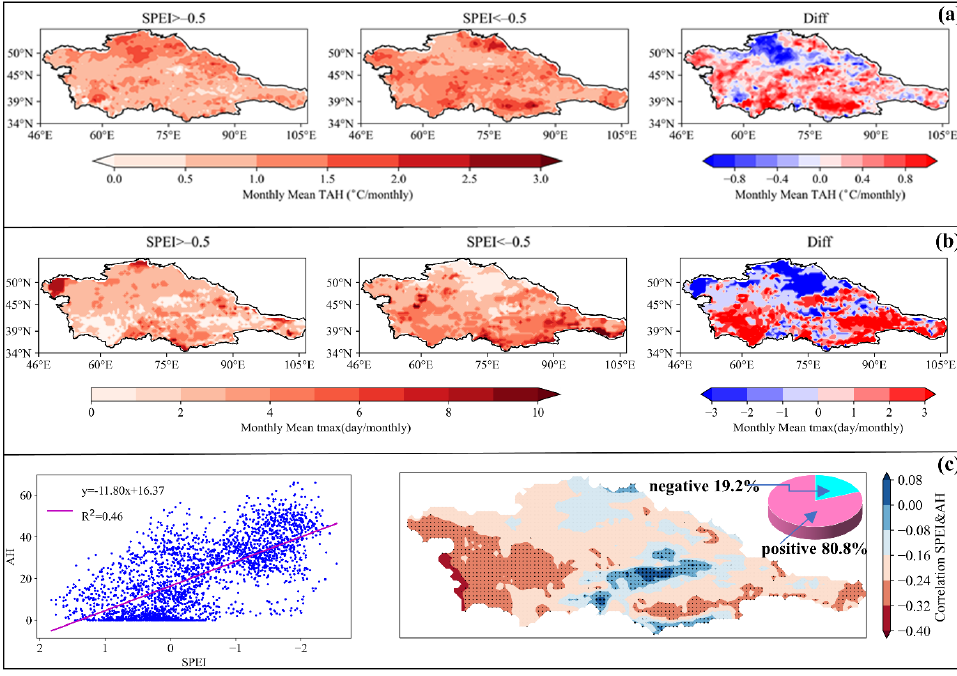
Figure 7. ( a ) Differences between TAH(SPEI < − 0.5) and TAH(SPEI > − 0.5); ( b ) differences between tmax (SPEI < − 0.5) and tmax (SPEI > − 0.5); ( c ) the SPEI (drought) and AH (accumulated heat) correlation.